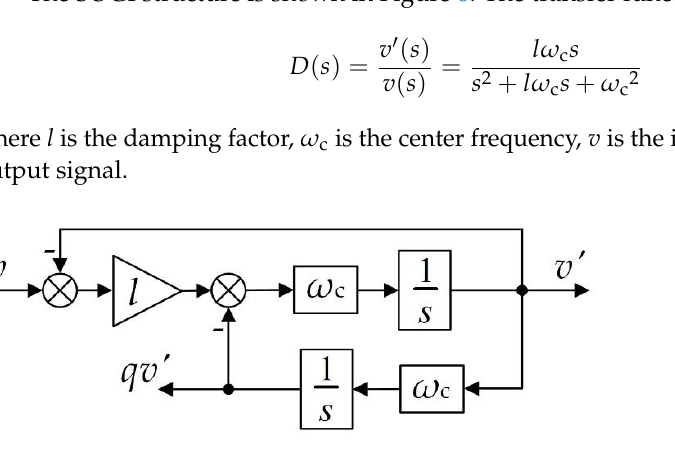
Figure 6. SOGI structure diagram.